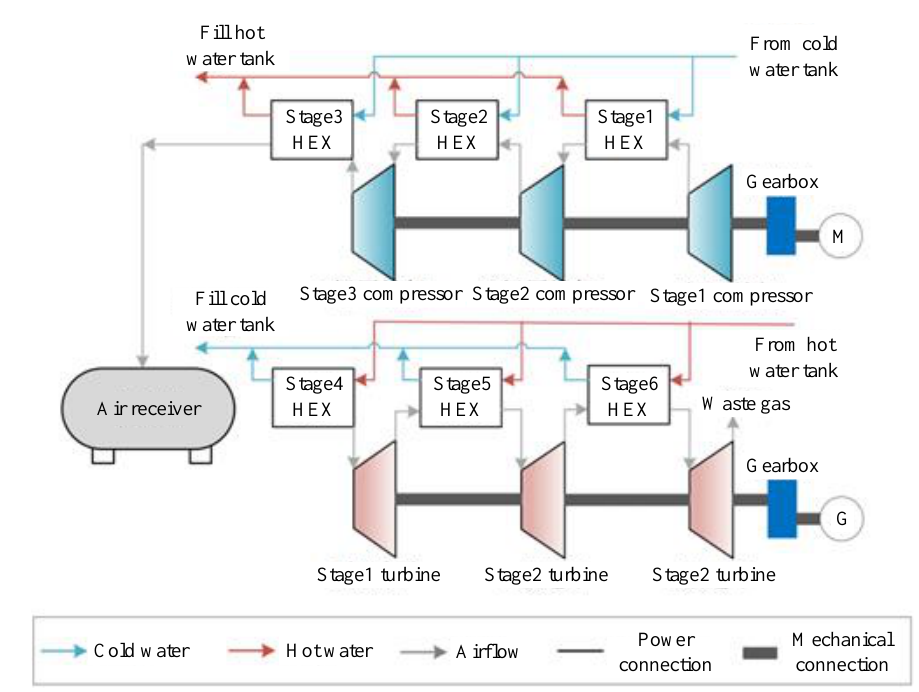
Figure 39. Schematic diagram of AA-CAES system structure for simulation.